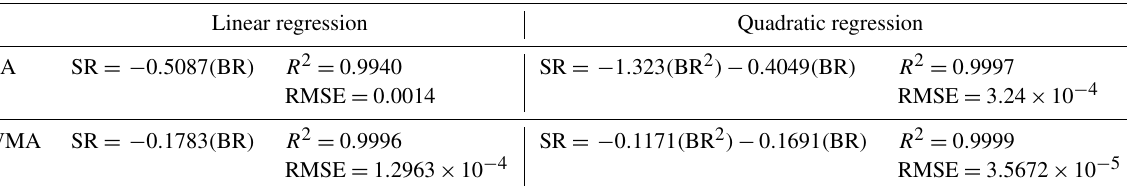
Table 2. Regression correlations between shift ratio (SR) and bandwidth ratio (BR) with the strength of the correlation in terms of R 2 and RMSE.